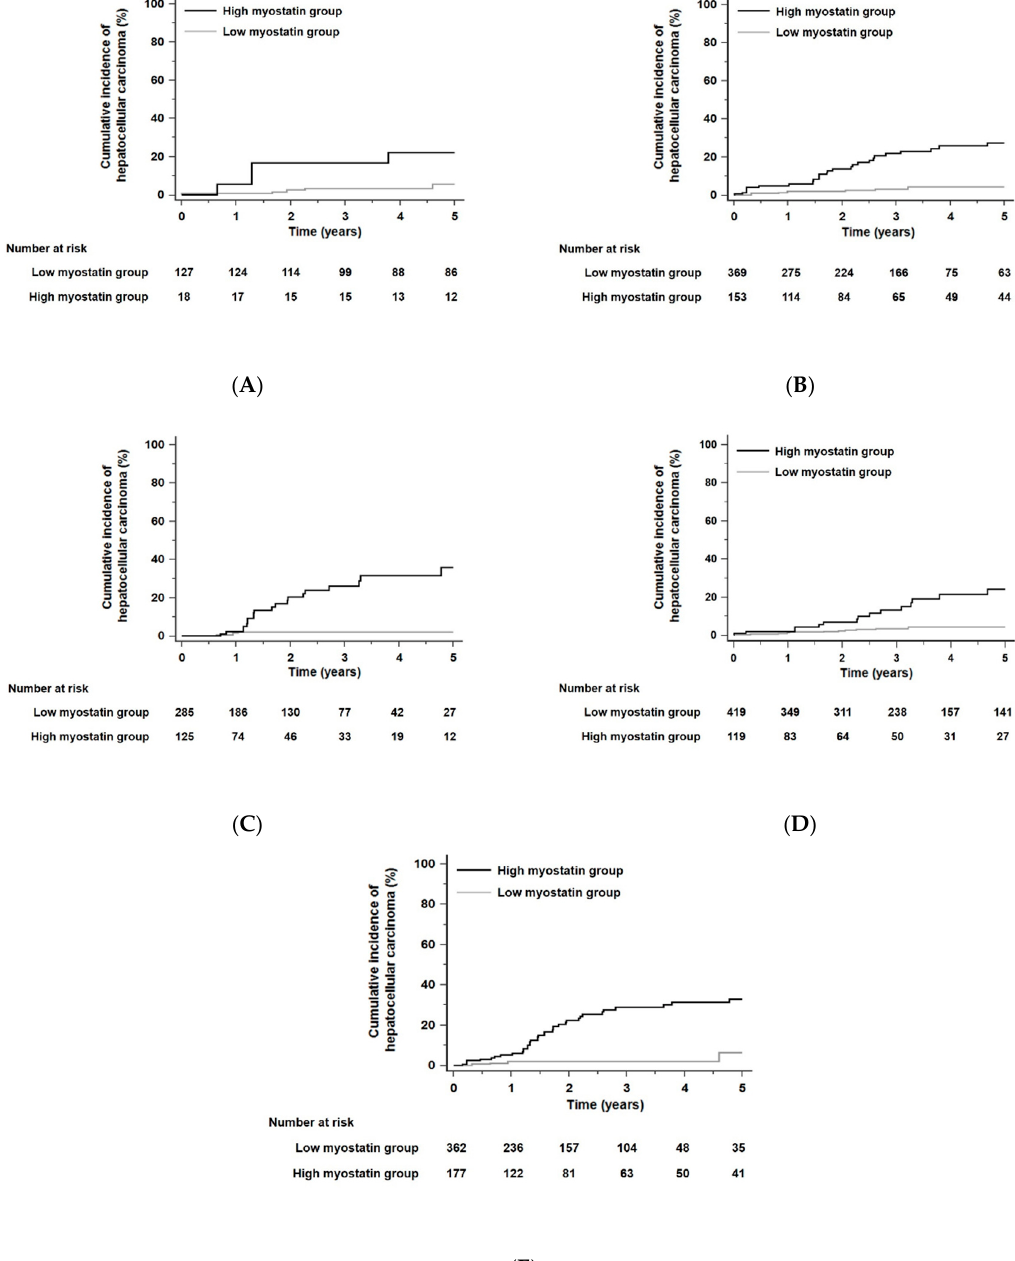
Figure 4. Kaplan–Meier estimates of HCC development in ALC patients in each group who had similar residual liver function according to the albumin–bilirubin (ALBI) grade or fibrosis-4 (FIB-4) scores. Risk stratification for HCC development according to serum myostatin levels among patients who were in ALBI grade 1 ( A ), grade 2 ( B ), and grade 3 ( C ) (all p < 0.01 by log-rank test). Risk stratification for HCC development according to serum myostatin levels among patients who had low FIB-4 scores ( ≤ 6.46, median value) ( D ) and high FIB-4 scores (> 6.46) ( E ) (all p < 0.001 by log-rank test). Abbreviations: ALBI, albumin–bilirubin grade; ALC, alcoholic liver cirrhosis; FIB-4, fibrosis-4; HCC, hepatocellular carcinoma.